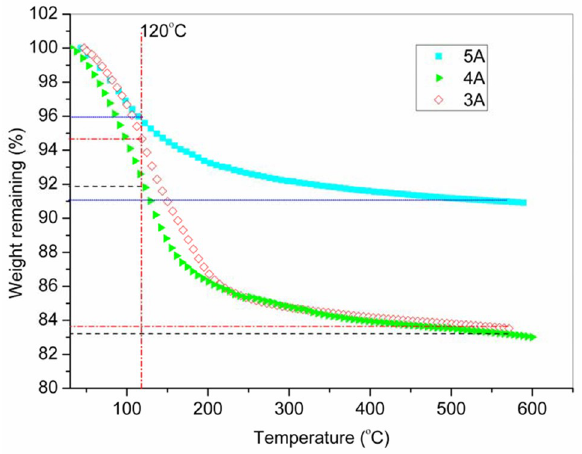
Figure 1. Thermogravimetric analyses (TGA) traces of molecular sieves (3A, 4A, and 5A) saturated by water vapor (1 atm, 25 °C).